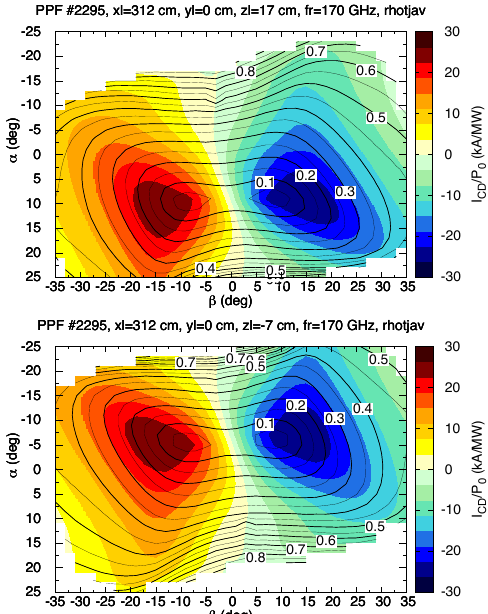
Fig. 2. Calculated driven current per unit power for the top (top) and bottom (bottom) equatorial launchers with varying poloidal ( a ) and toroidal ( b ) angles. Driven current average location is represented by black contours.